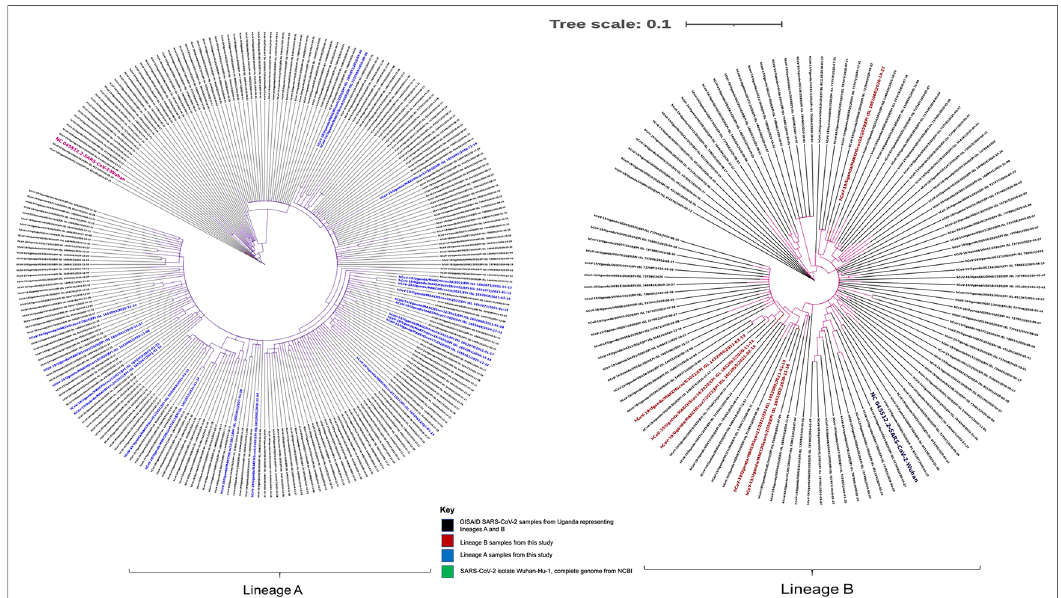
Figure 1. Phylogenetic analysis of 356 SARS-CoV-2 genome isolates (Lineages A and B) from Uganda.